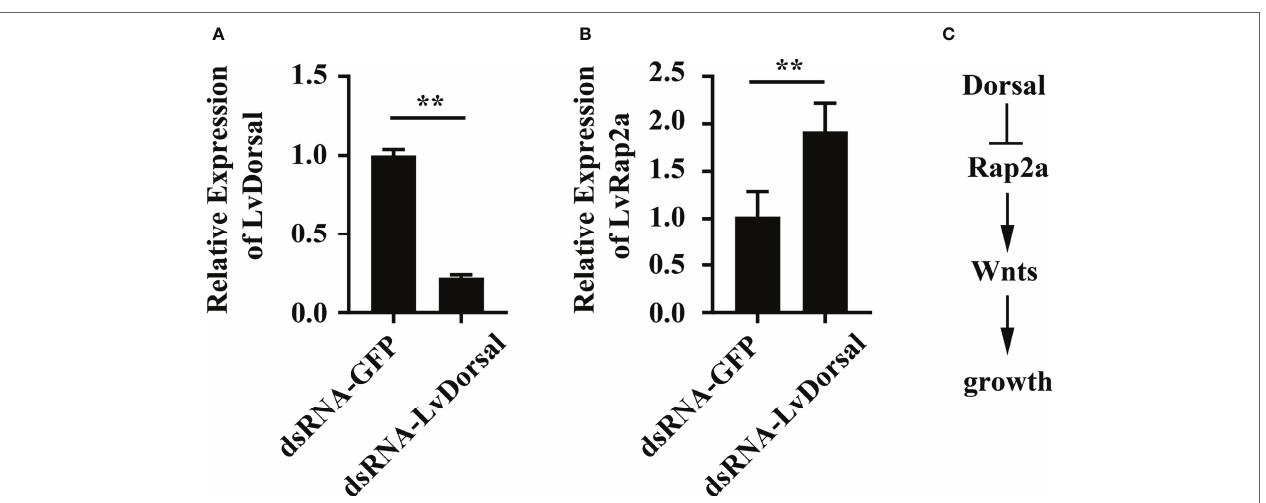
FIGURE 7 | The expression of LvRap2a was negatively regulated by LvDorsal i n vivo . (A) The RNAi efficiency of dsRNA-LvDorsal. Samples were taken at 48 h after dsRNA injection. (B) Expression of LvRap2a in LvDorsal silenced shrimp was detected by qRT-PCR analysis. (C) A potential model about the effect of LvDorsal on Rap2a-Wnt cascade mediated shrimp growth. Asterisks indicate significant differences (** p < 0.01). All the experiments (A, B) were performed two times with identical